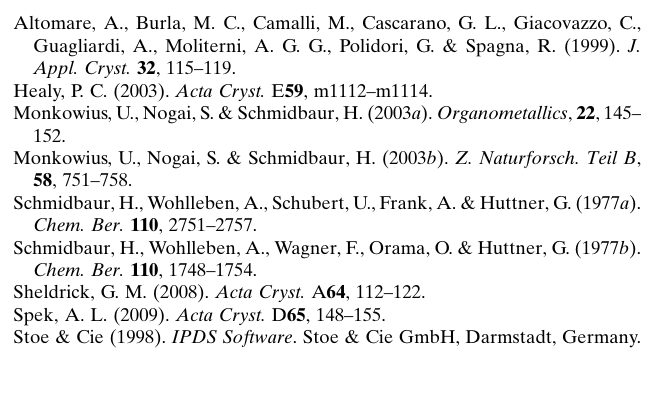
Stoe IPDS diffractometer Absorption correction: analytical